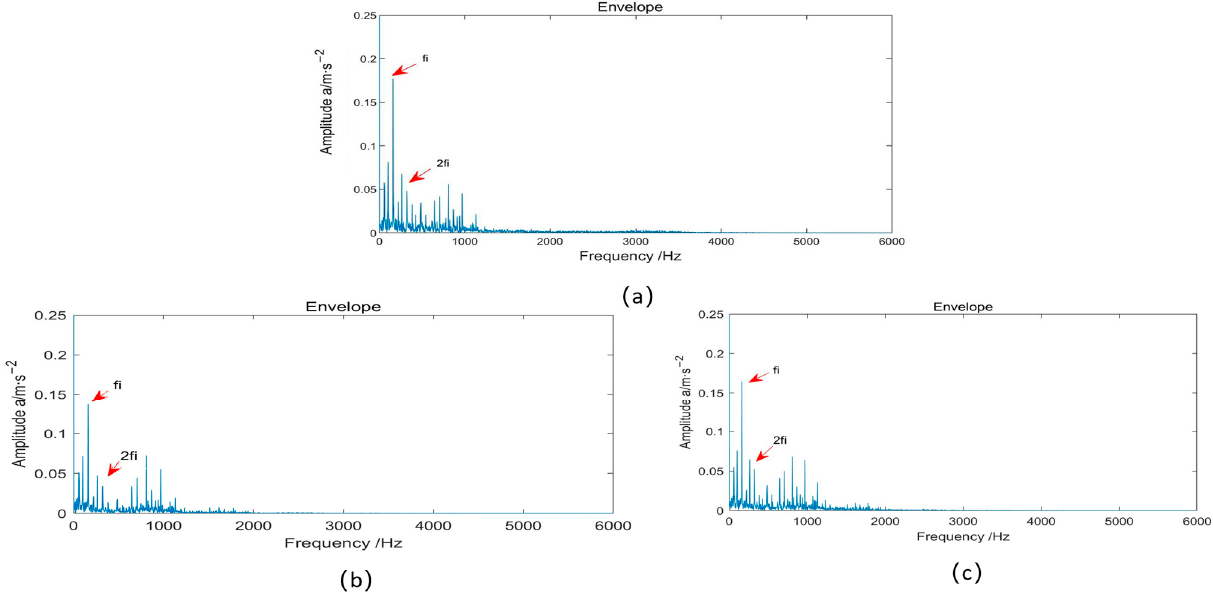
Figure 13. Envelope spectrum analysis of reconstructed signals by different methods: ( a ) EMD; ( b ) traditional VMD; ( c ) improved VMD.